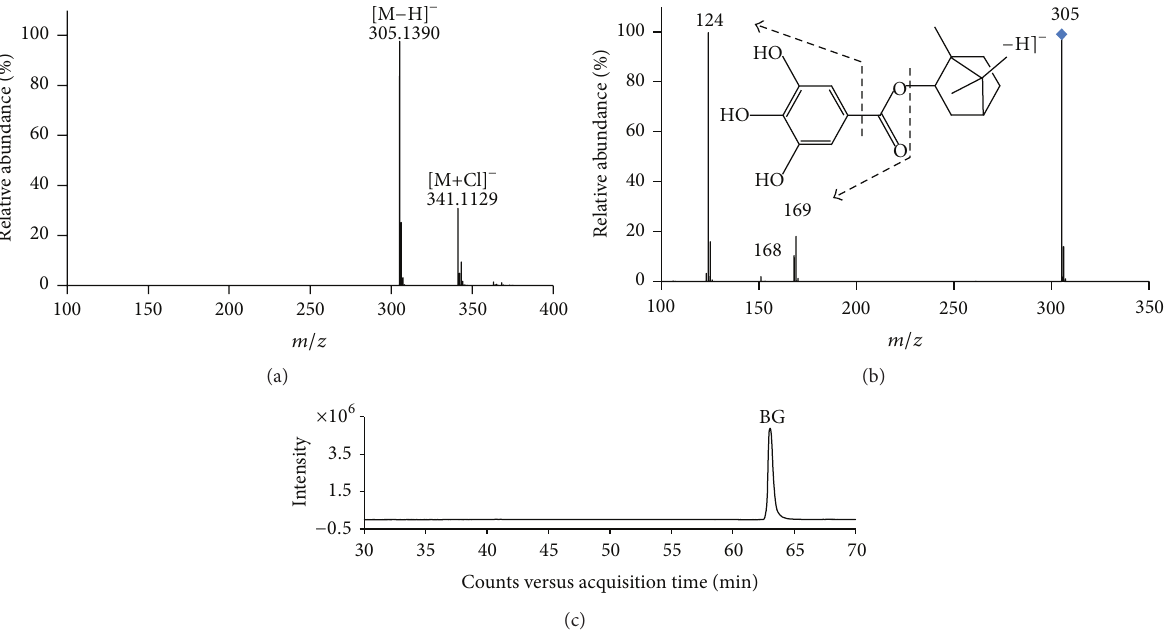
Figure 2: MS, MS/MS spectrum, and total ion chromatogram (TIC) of reference BG (a) MS spectrum; (b) MS/MS spectrum, and the predominant fragmentation pattern; (c) TIC of BG. The chromatographic separation is performed on an Agilent TC-C 18 column (250mm × 4.6 mm, 5 𝜇 m) with gradient elution using methanol and water containing 0.2% (V: V) formic acid as the mobile phase. Under the proposed condition, the retention time of BG was determined to be 63.0